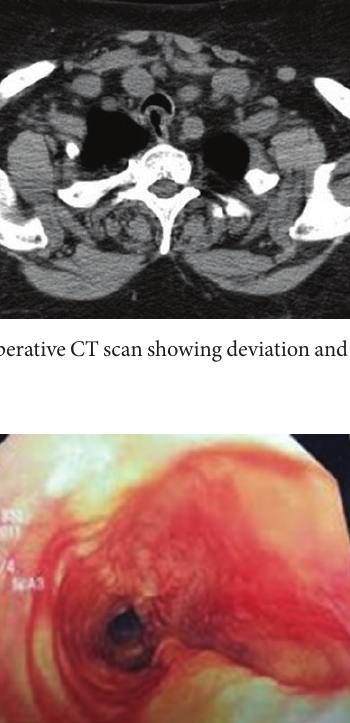
Figure 4: Bronchoscopy showing tracheomalacia on postoperative week no. 17. (note: complete